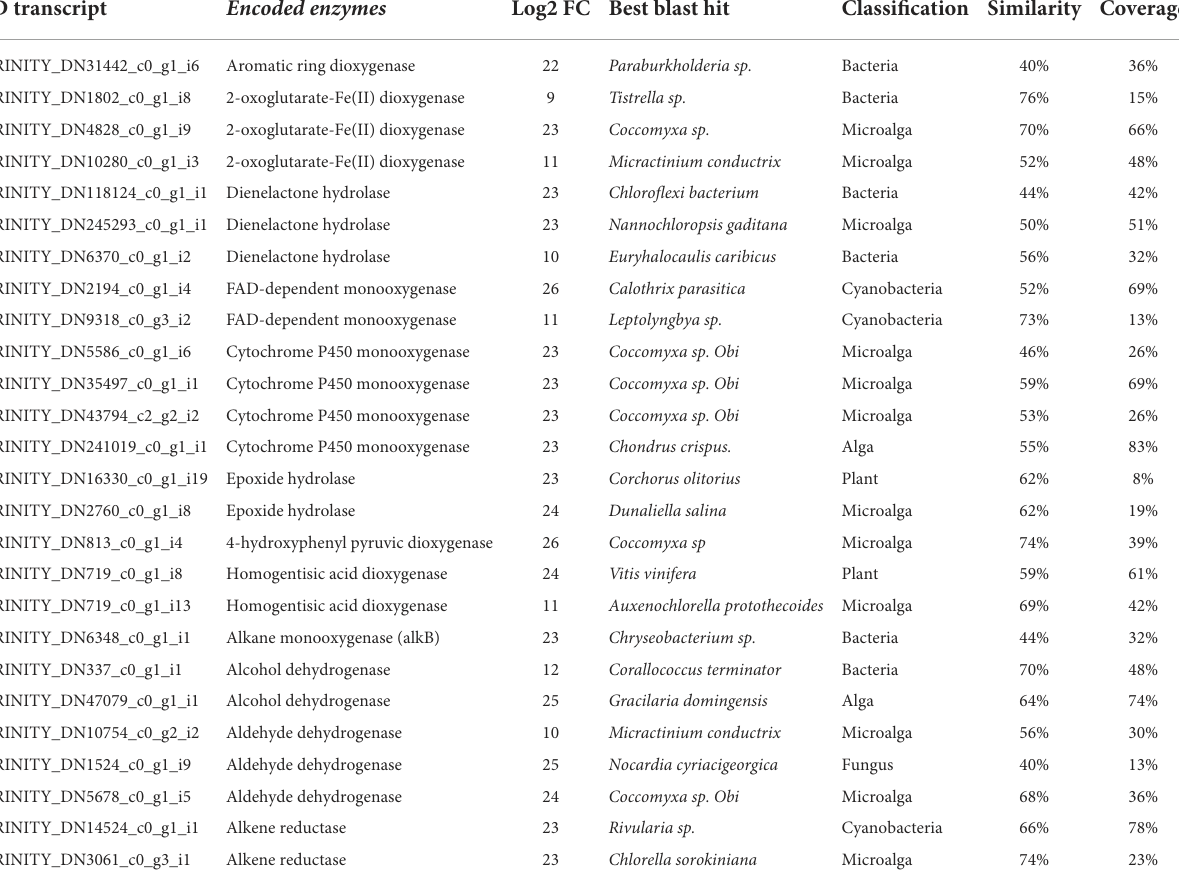
TABLE 2 Overexpressed genes potentially involve in anthracene and linear hydrocarbons